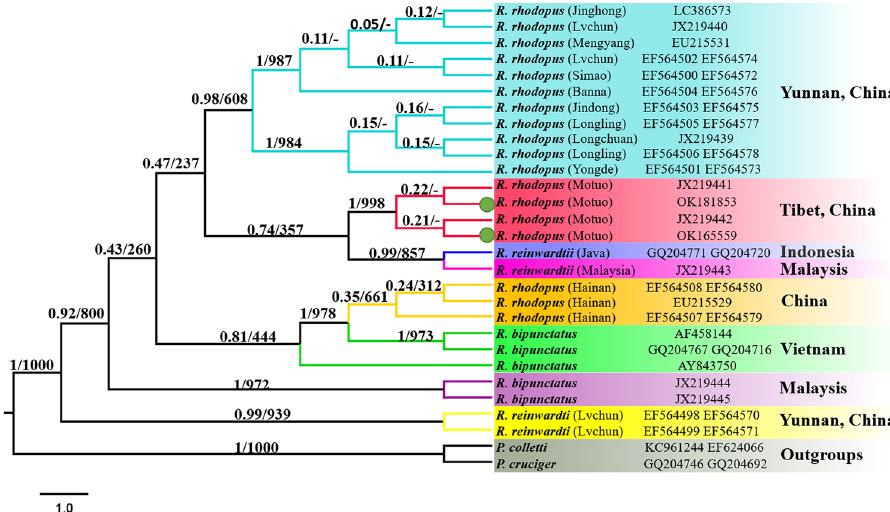
Figure 7. BI and ML analysis of Rhacophorus rhodopus , Rhacophorus bipunctatus and Rhacophorus reinwardtii, based on 12S and 16S. Polypedates colletti and Polypedates cruciger as outgroups. Tree topologies produced by BI and ML analyses were equivalent. Bayesian posterior probability (PP) and bootstrap support (BP) values for ML analyses are shown in order on the